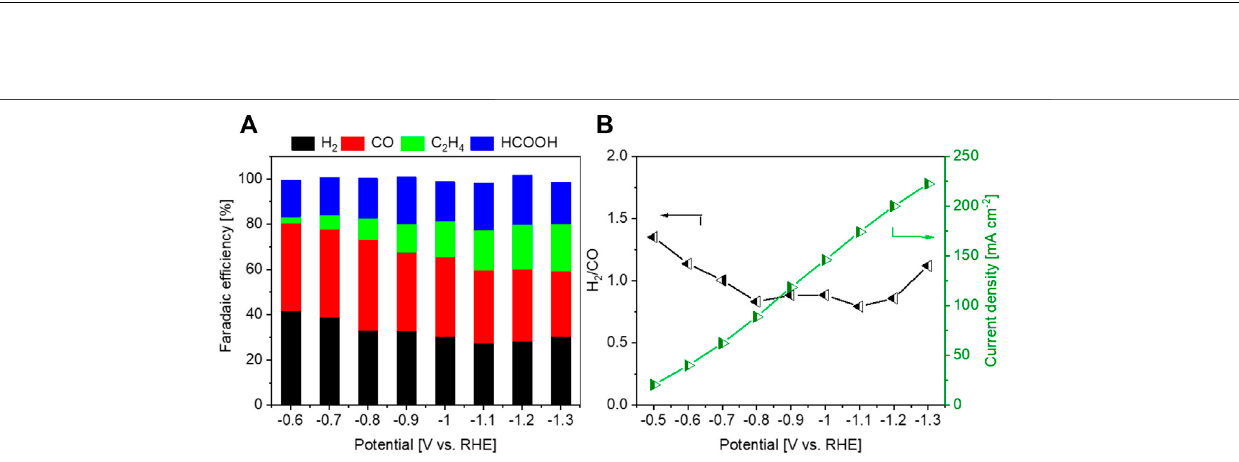
FIGURE 8 | Sample Cu 2 O-Al-3 tested in a fl ow cell with 1.0 M KOH electrolyte. (A) FE values for main products, (B) H 2 /CO ratios ofsyngas and geometric current densities.